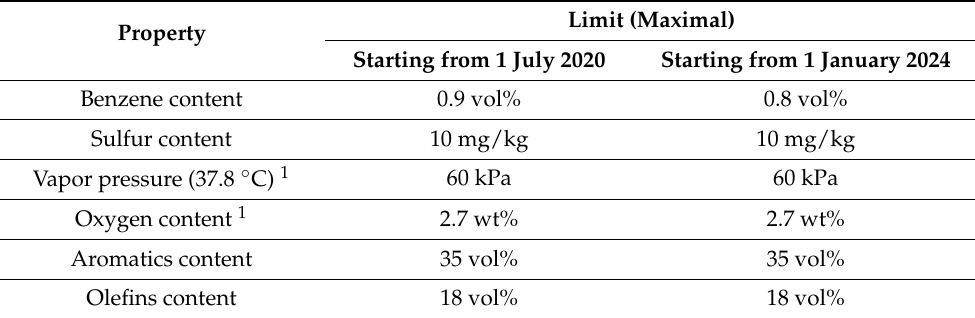
Table 5. The standards for the composition of gasoline (including E3 gasohol) in Taiwan.